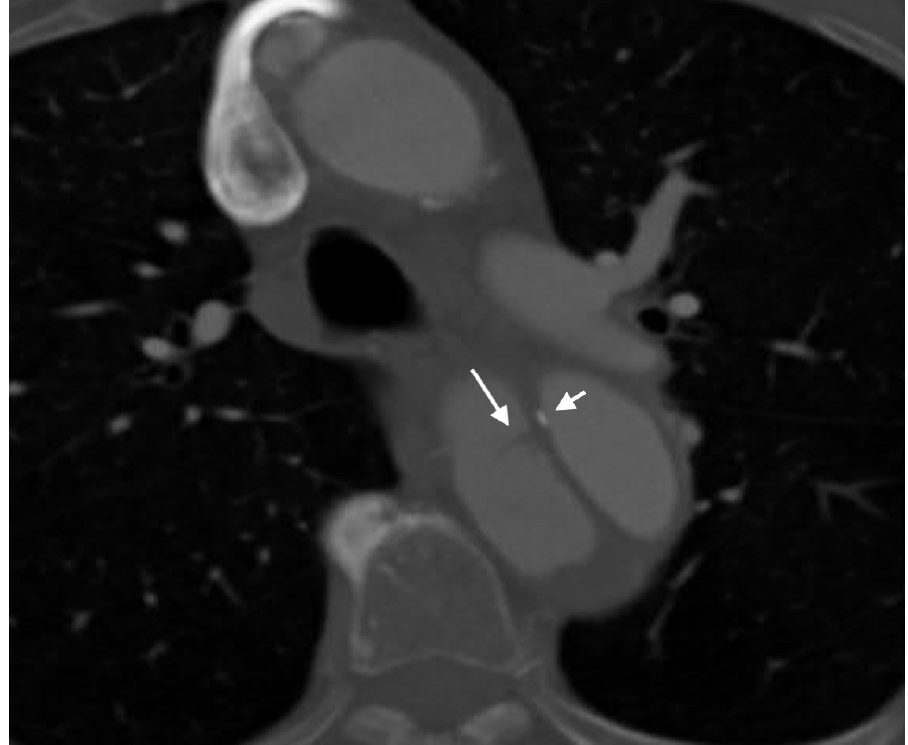
Figure 6. Axial image of type A aortic dissection demonstrating both the cobweb sign (long arrow) and eccentric calcification in the dissection flap (short arrow) in the descending aorta. Note that the eccentric calcification abuts the true lumen.